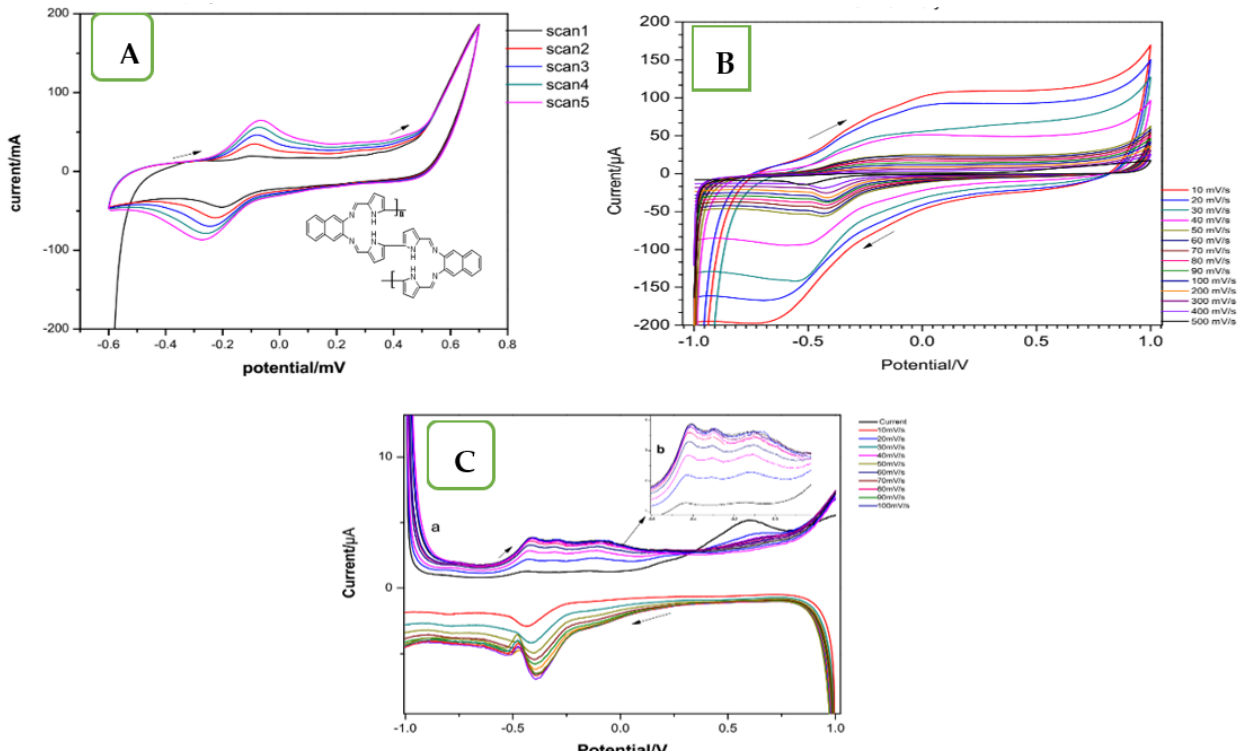
Figure 6. Cyclic voltammogram for electrodeposition of the BPND ligand on an SPCE in a 4 mL of a 1:1 mixture of 0.1 mM HCl and DMF recorded at the scan rate of 50 mV/s ( A ), a CV data of SPCE/BPND ( B ) and SWV of both anodic and cathodic waves ( C ) both in PBS of pH 7.0 in the potential window of − 1 to 1 V vs. Ag/AgCl.